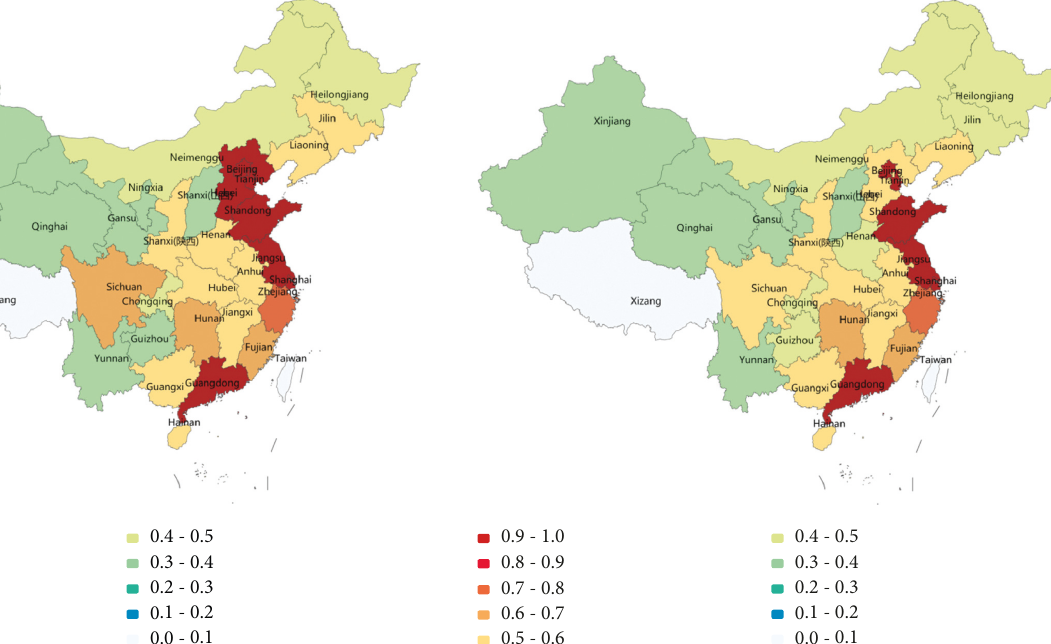
Figure 7: 2018 EEE value in China.